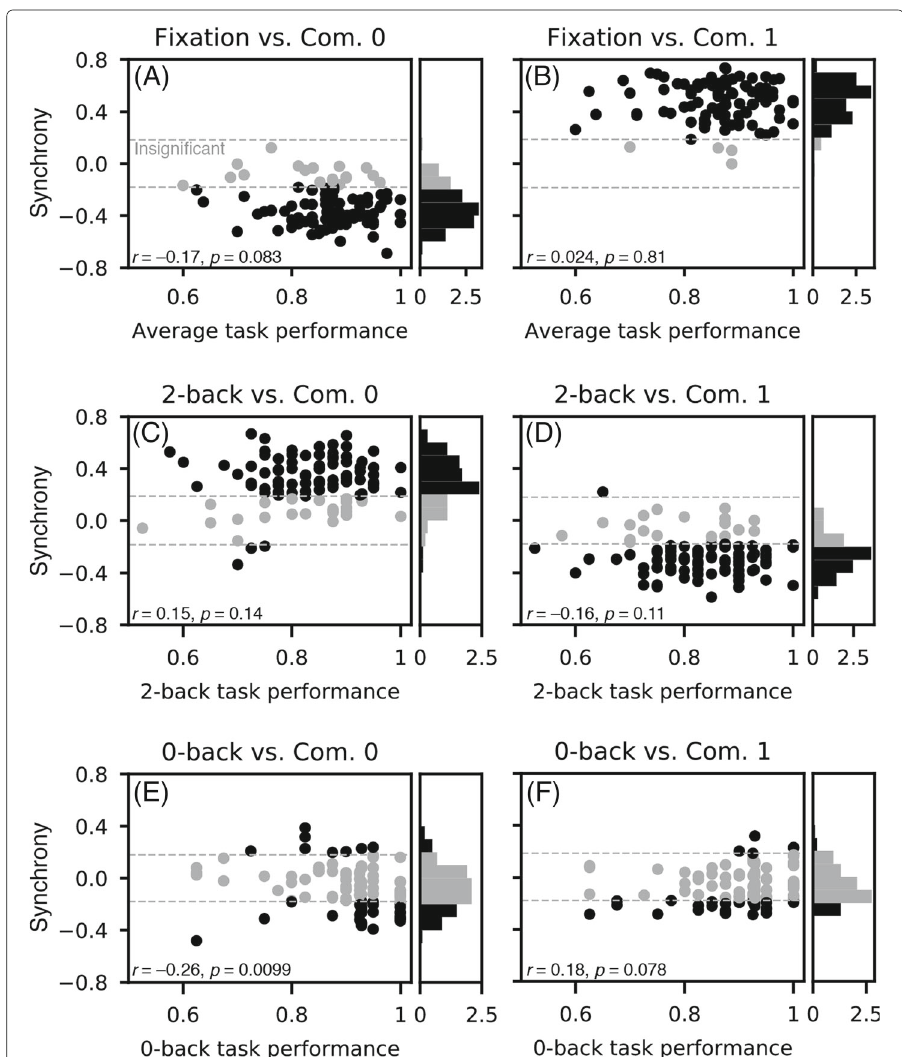
Fig. 3 Task performance versus community-task synchrony. Gray regions represent insignificant synchrony (measured as Pearson correlation) between tasks and communities after multiple comparisons correction (100 hypotheses). First-axis values in ( c - f ) are task performance accuracies of the respective task, while the average of 0-back and 2-back is used ( a - b ). In no case does task performance correlate significantly with community-task synchrony (6